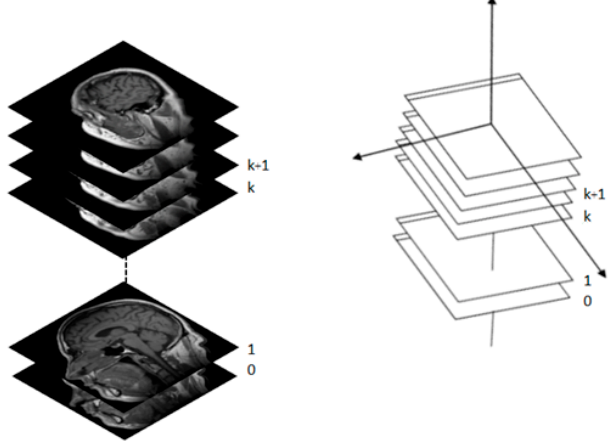
Figure 8. The CT images sequence used in 3D medical rendering.